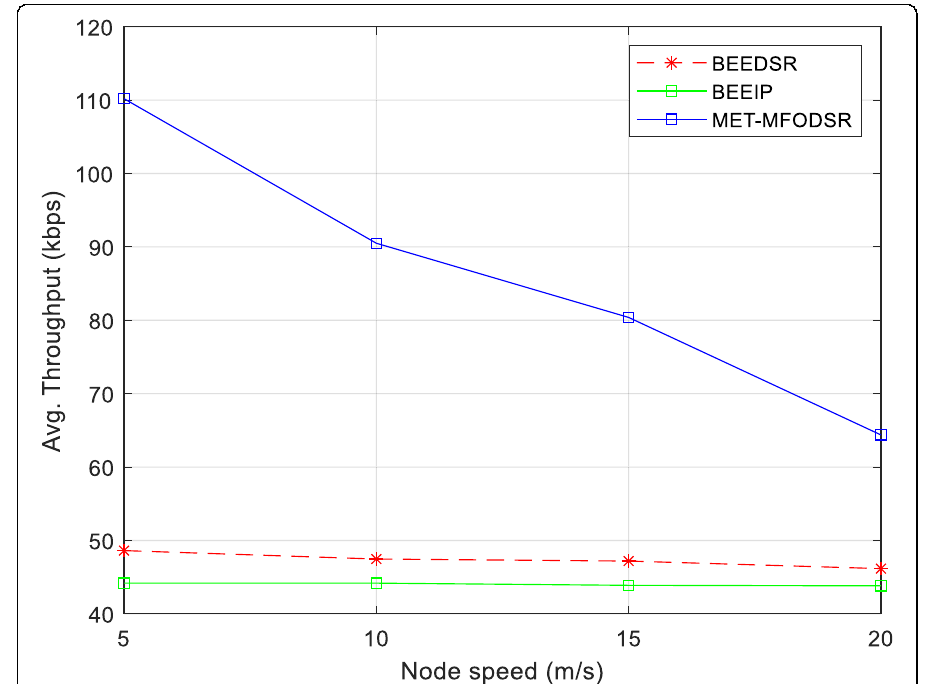
Fig. 9 Average throughput simulation results for BEEDSR, BeeIP, and MET-MFODSR. The simulation results of the average throughput under the node speed